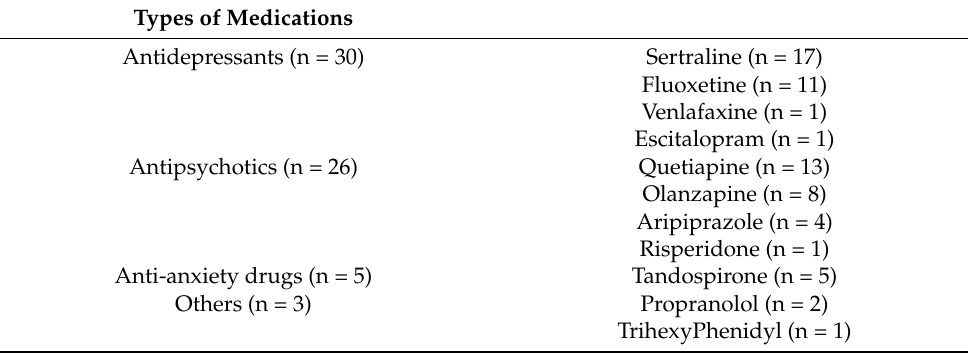
Table 1. Medications in MDDs. Types of